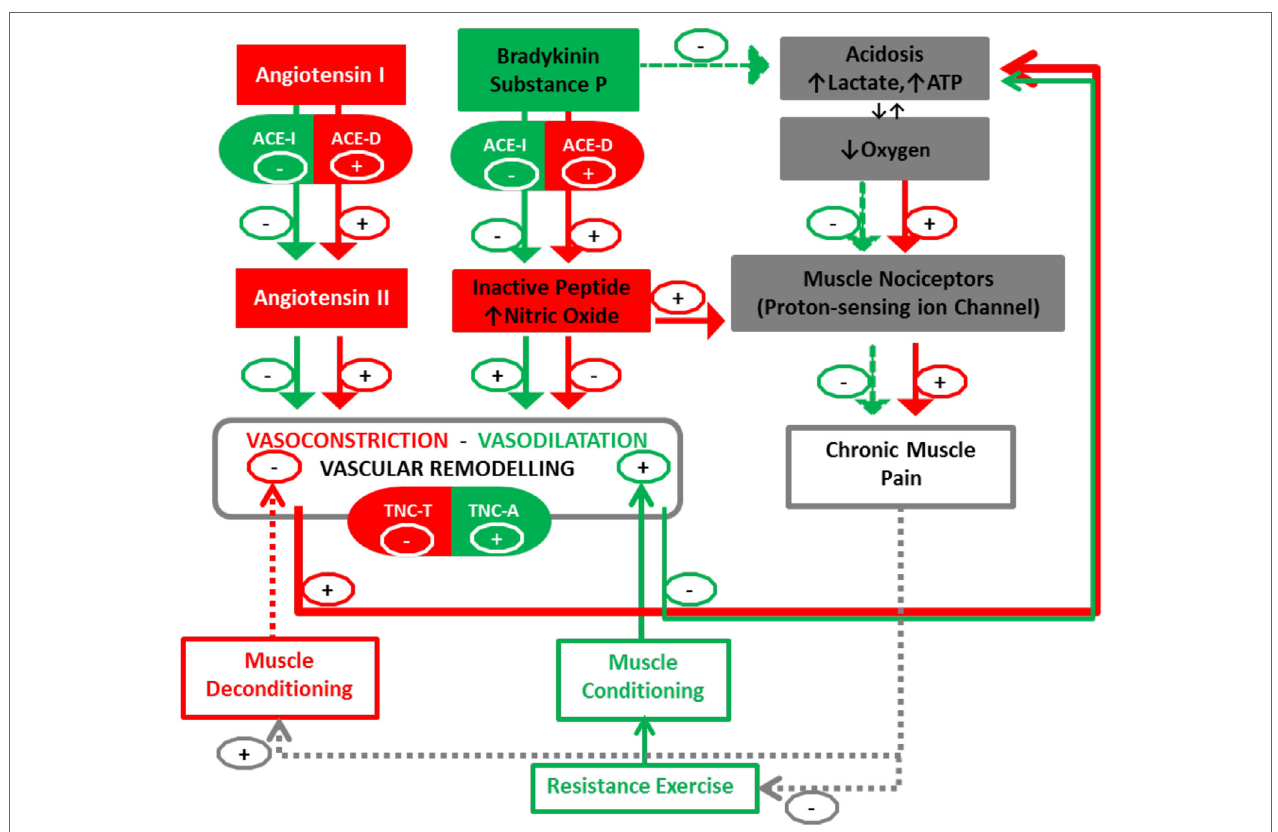
FiGUre 1 | Peripheral blood perfusion in relationship with angiogenic factors (ACE and TNC) and chronic muscle pain. Interactions between muscle deconditioning/ conditioning responses and the Angio-adaptation process. Arrows ( + ) indicate promotion and Arrows ( − ) indicate reduction. Documented interactions are fully colored in green and red, while dotted lines represent our postulated interactions in this pathway. ACE I, angiotensin-converting enzyme insertion; ACE D, angiotensin-converting enzyme deletion; TNC, Tenascin-C (rs2104772); A, adenine; T, thymine. The TNC-T and ACE-D polymorphism may result in a less-efficient vascular remodeling-perfusion and exacerbation of muscle pain by an increase of nitric oxide (NO) and acidosis-related